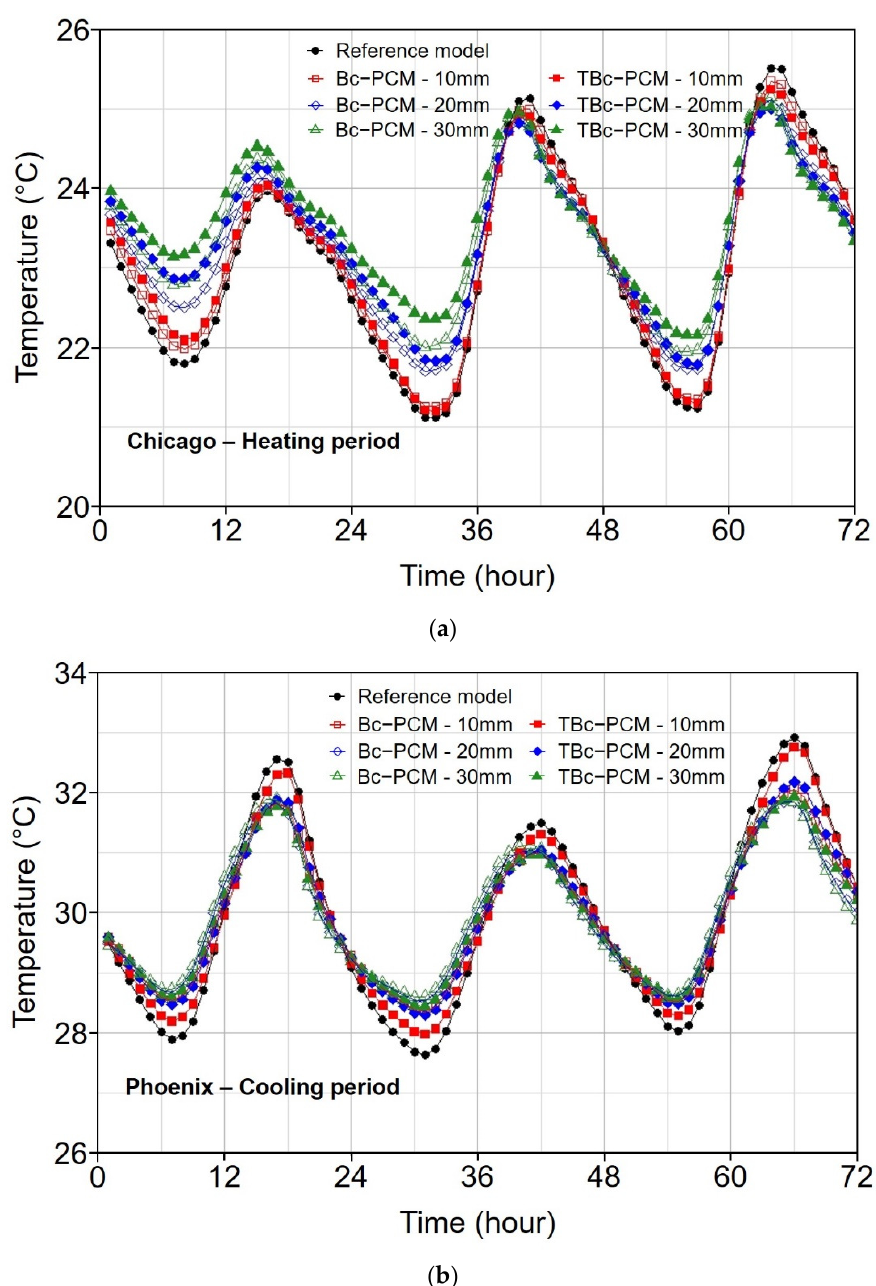
Figure 7. Monthly reduced ( a ) heating and ( b ) cooling energy load for four cities.